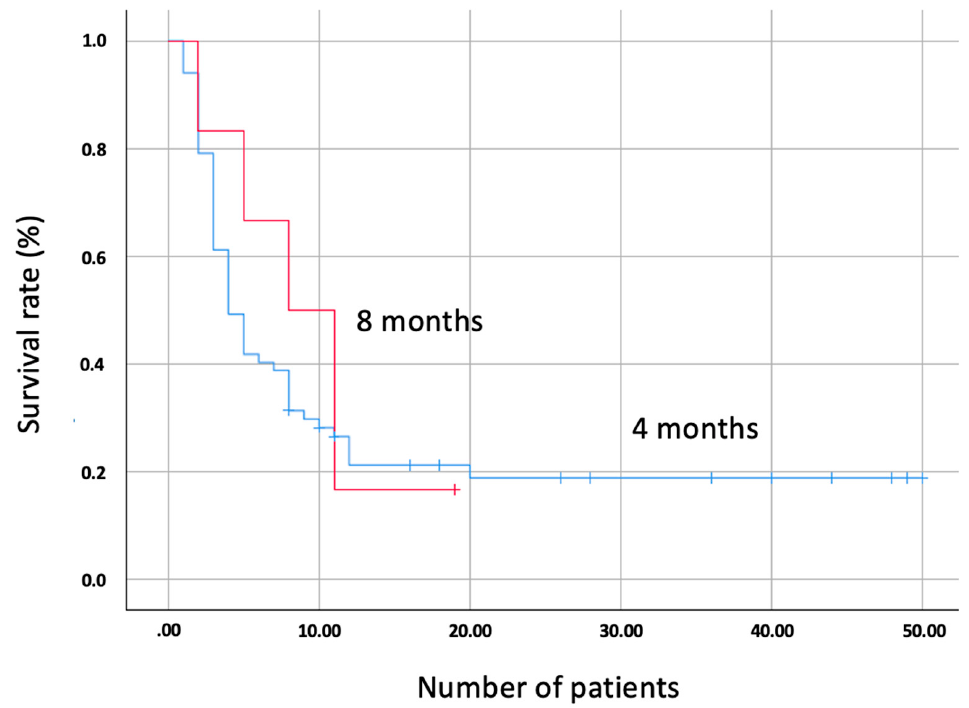
Figure 2. Kaplan–Meier curve showing the comparison of progression-free survival (PFS) between patients with lost MMR system gene expression (red) and conserved (blue).